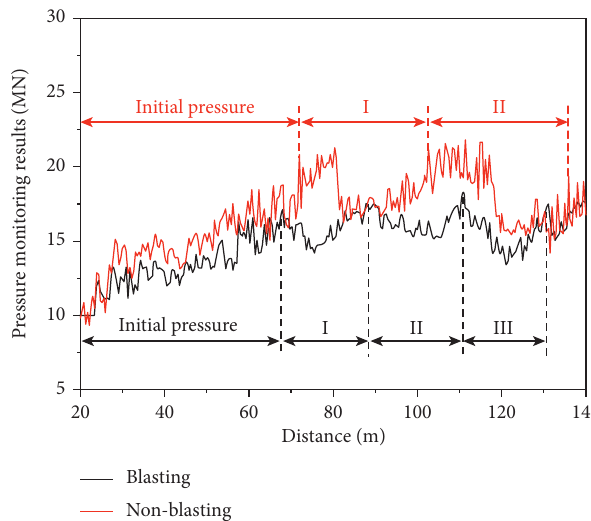
Figure 14: Monitoring curves of the working resistance of hy- draulic